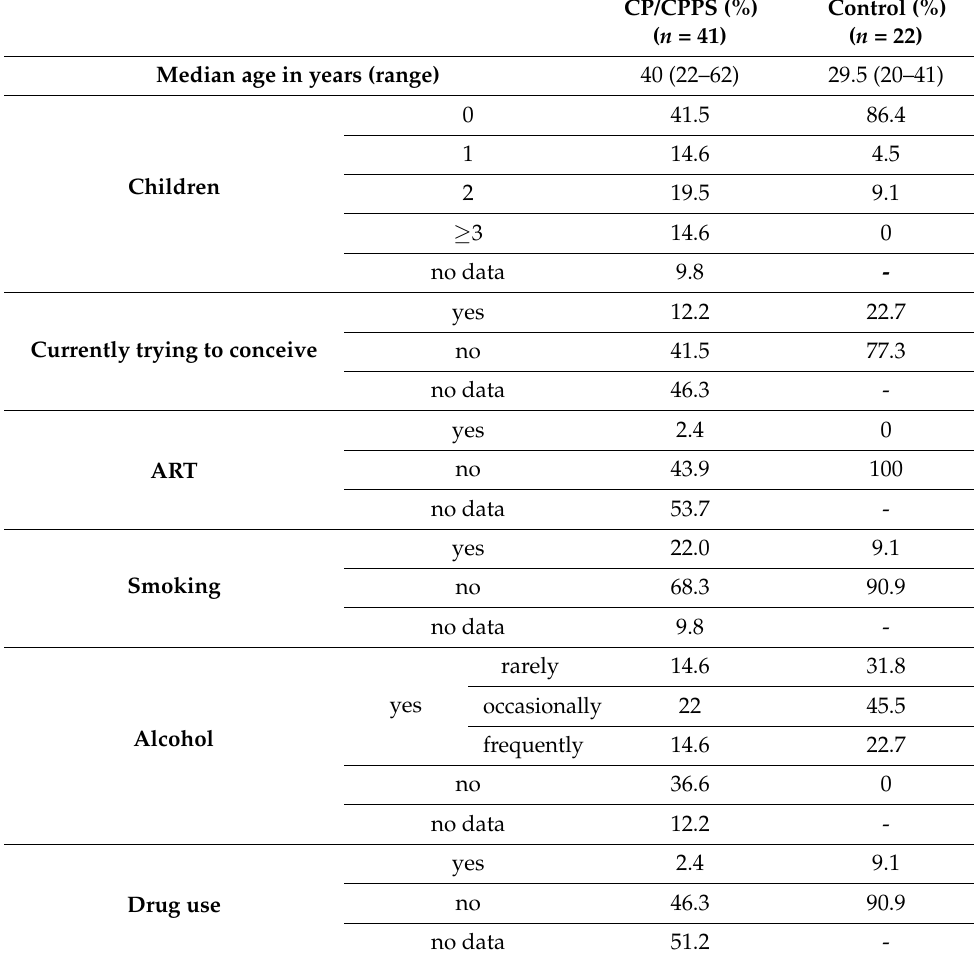
Table 2. Demographic characteristics, fertility data and lifestyle aspects of CP/CPPS patients and control group including number of children, couples currently trying to conceive, fertility treatment in terms of assisted reproductive technology (ART), smoking, alcohol and drug